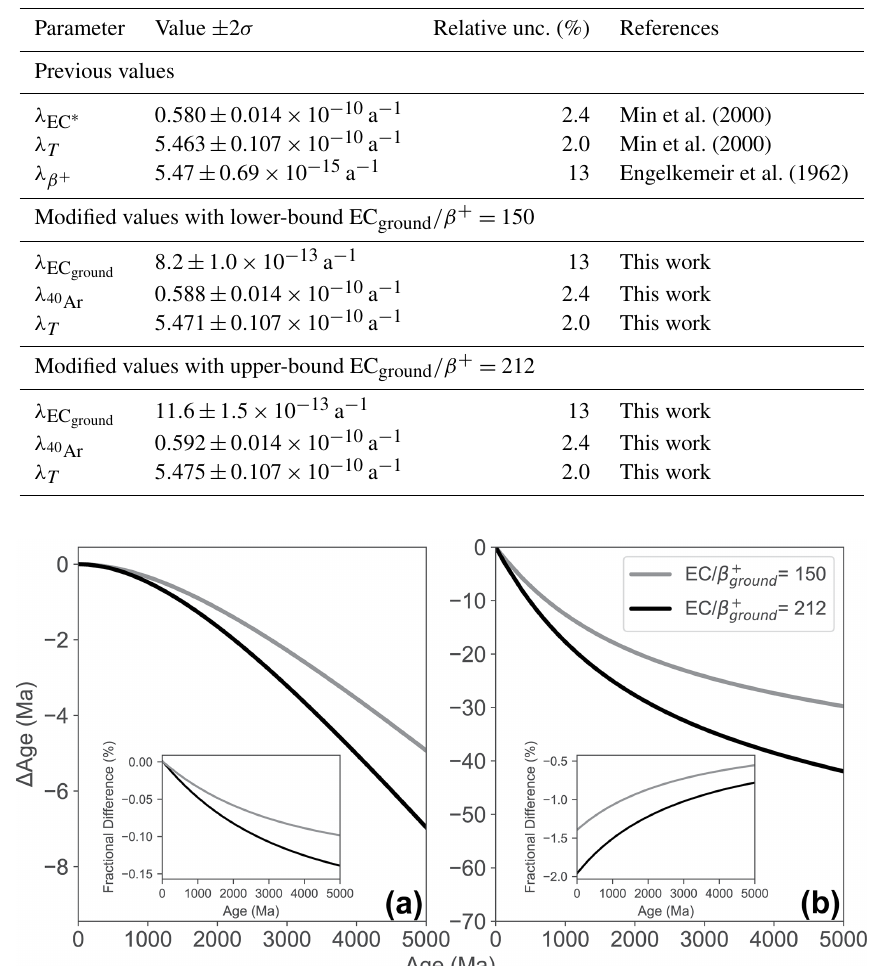
Table 1. Evaluations of decay mode branches and total decay constant used in age determination. λ 40 Ar is the partial decay constant for the 40 Ar branch, including both the EC* and EC ground components. Uncertainties from the β + /β − and EC ground /β + do not substantially change the uncertainties in λ 40 or λ T . Ar